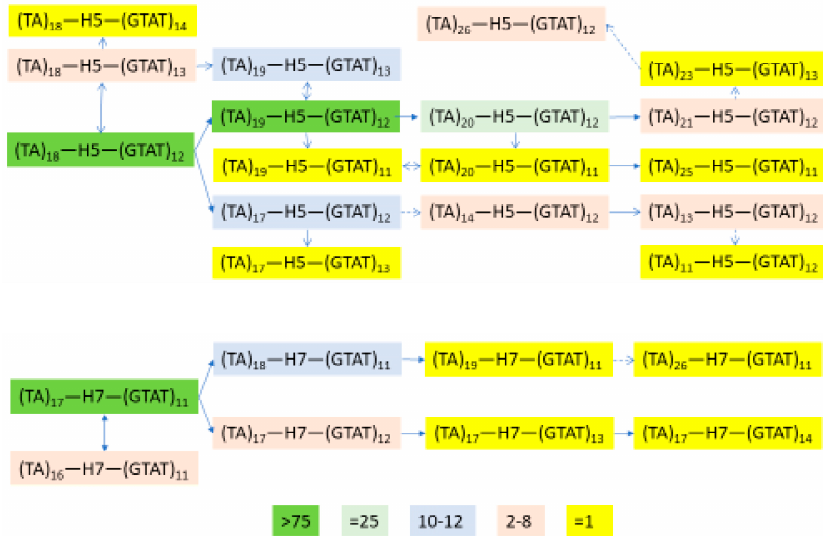
Figure 7. Schematic of STRP evolution flanking the two haplotypes with evidence of selection. The 25 STRP haplotypes for H5 and H7 in the populations studied are shown; color highlighting indicates their frequency counts. See Table S2 for more details. H5 = TCGAGGC in Figure 4; H7 = TCGAAGT in Figure 4. The core haplotypes correspond to H5 and H7 in Li et al. [41]; the shorter core in this study does not allow H6 to be distinguished. Given the assumed mutation rates at the STRPs, these are consistent with recent selection on the chromosomes and compatible with selection associated with the origins of agriculture.